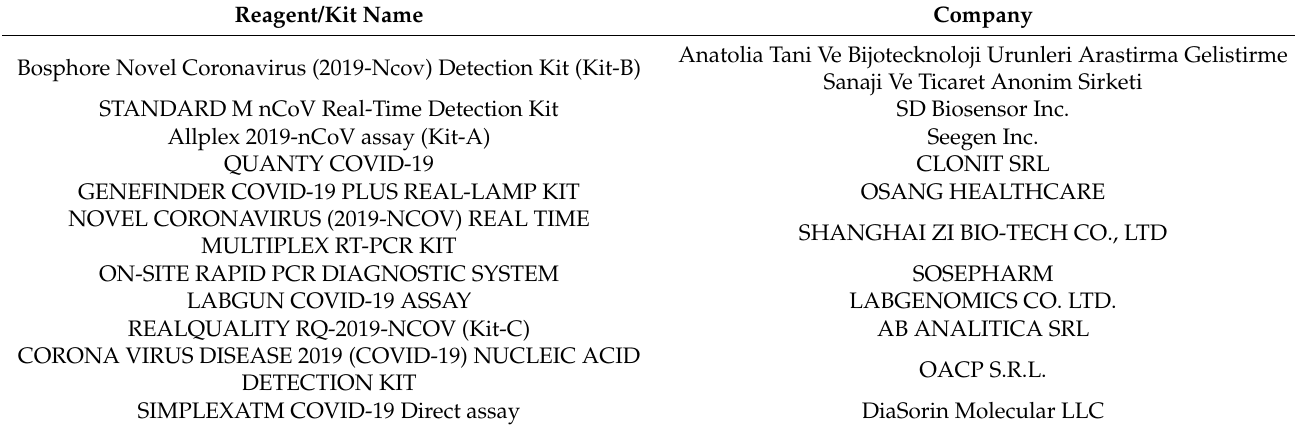
Table 1. List of reagents indicated by Italian Istituto Superiore di Sanit à as the recommended diagnostic tools during the first pandemic period (March